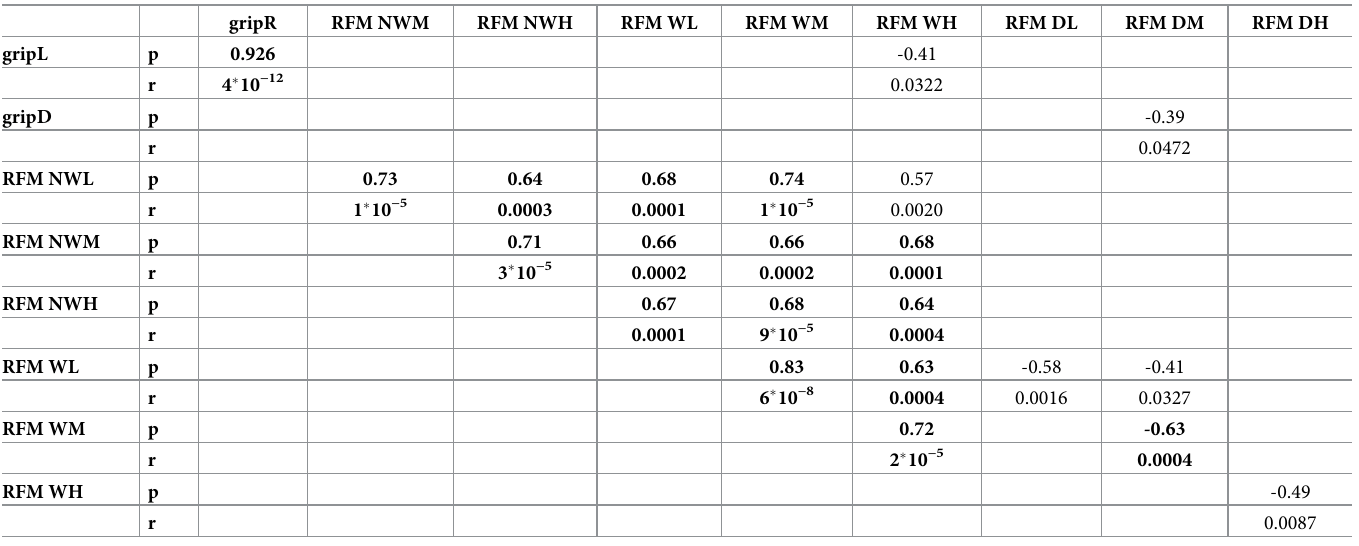
Table 2. Significant correlations between dependent variables of hand use.